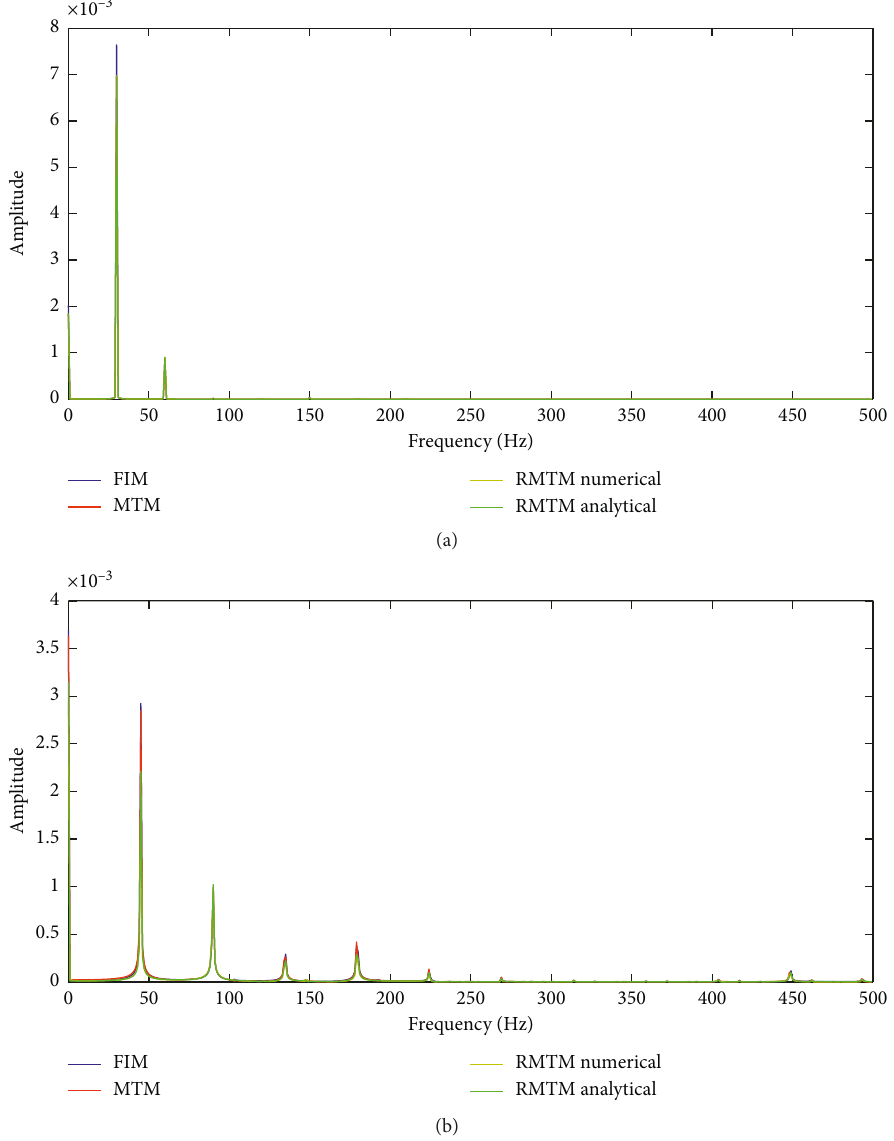
Figure 7: Frequency spectrum of soft impact and hard impact using different methods. (a) Twenty-mode discretization: damping ratio ξ � 0 . 02, ω � 60 Hz, and soft impact k ∗ � 1 . 3 ( k � 1 × 10 3 N/m ) . (b) Twenty-mode discretization: damping ratio ξ � 0 . 02, ω � 90 Hz, and hard impact k ∗ � 13000 ( k � 1 × 10 7 N/m )